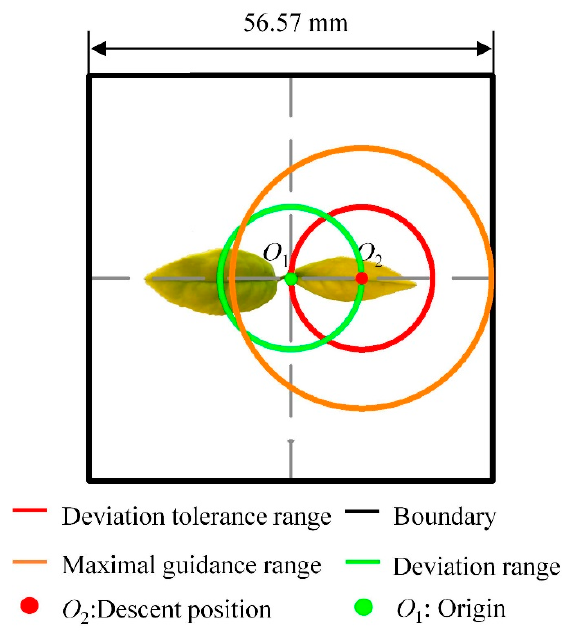
Figure 20. Limitation of maximal guidance range.